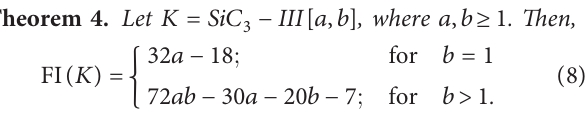
, f , f , f , f , f , and f with given 13 15 17 18 20 22 24